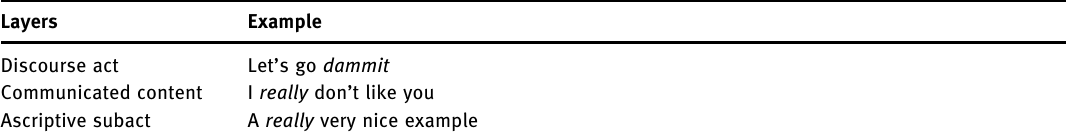
Table 2: Lexical devices of Emphasis at the di ff erent layers of